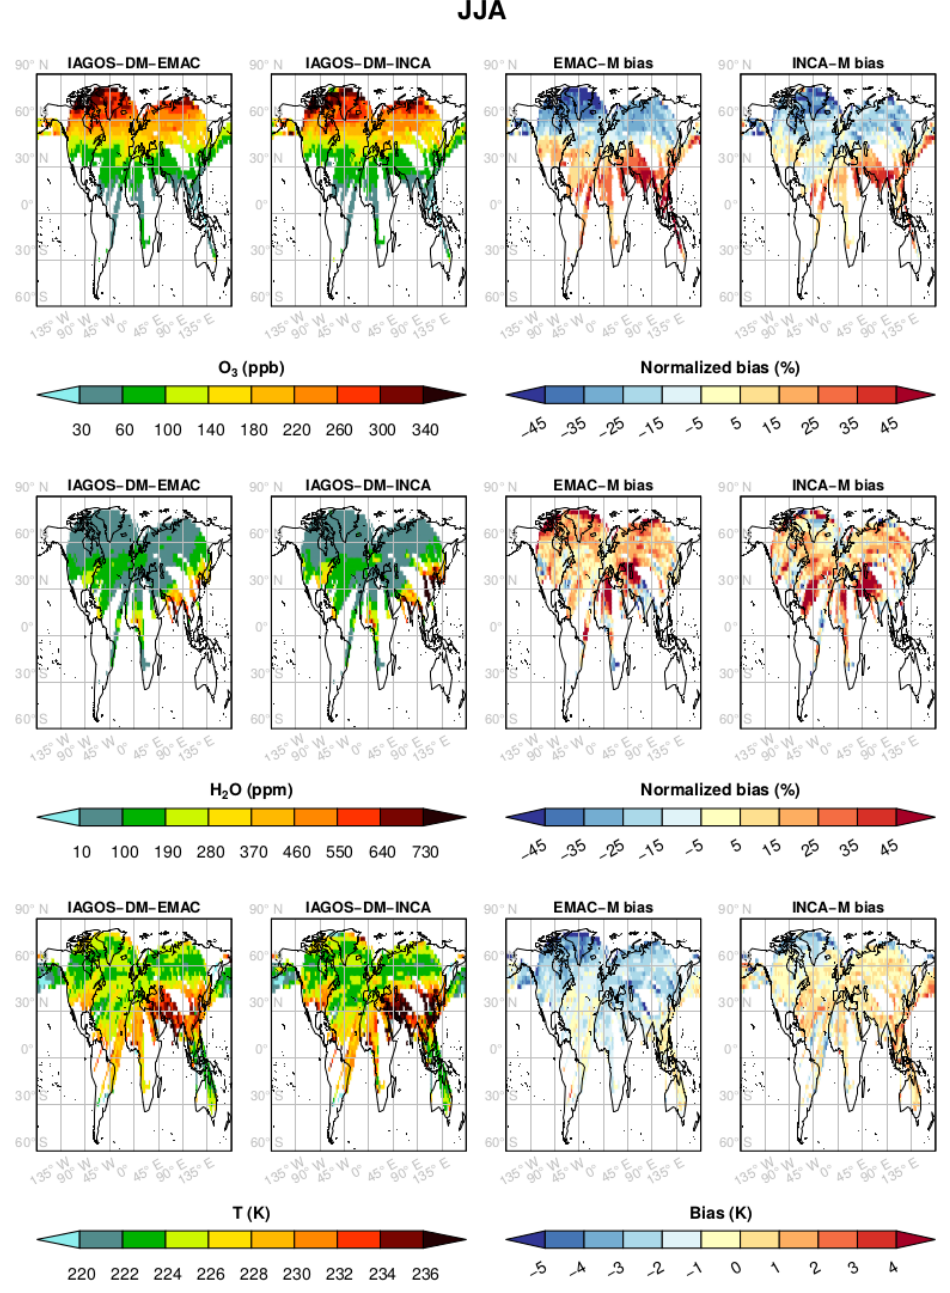
Figure A11. Same as Fig. A8 for boreal